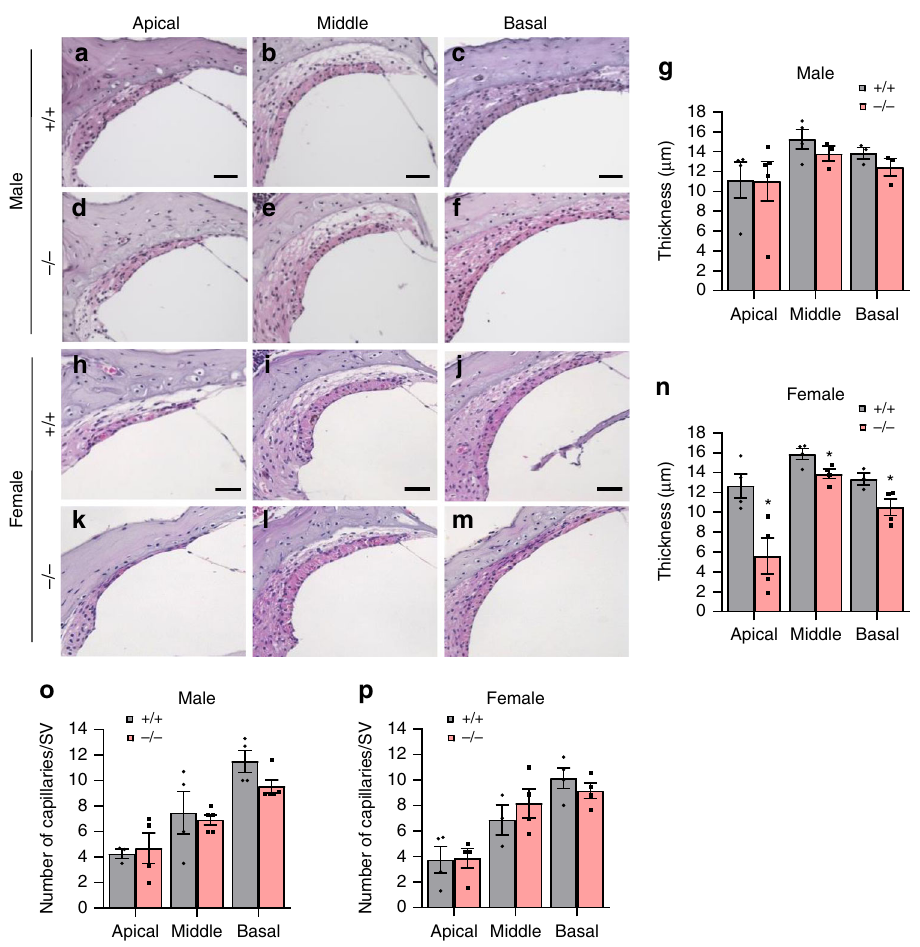
Fig. 4 Assessment of SV thickness and capillary number. a – n SV regions in the apical, middle, and basal regions of cochlear tissues from male ( a – f ) and female ( h – m ) Gsta4 + / + and Gsta4 − / − mice after cisplatin treatment. Scale bar = 20 μ m. The thickness of SV in the apical, middle, and basal region of cochlear tissues from male ( g ) and female ( n ) Gsta4 + / + and Gsta4 − / − was measured. The quanti fi cation shows a mean of at least three independent experiments ( n = 3), * p < 0.05 vs. + / + (two-way ANOVA). Error bars represent ± s.e.m. o , p Numbers of endomucin-positive capillaries in the SVs in each region (apical, middle, and basal region) of cochlear tissues were counted and quanti fi ed in male ( o ) and female ( p ) Gsta4 + / + and Gsta4 − / − mice after cisplatin treatment. The quanti fi cation shows mean of at least three independent experiments ( n = 3). Error bars represent ± s.e.m. Source data are provided as a Source Data fi